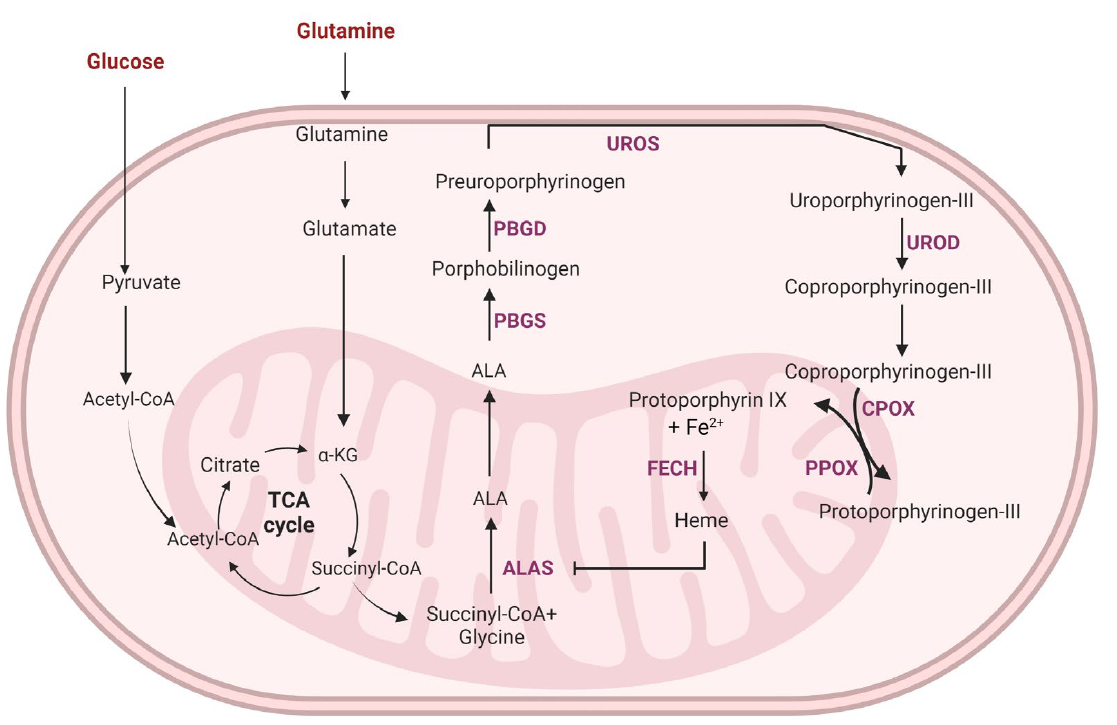
Figure 3. The heme biosynthesis is connected with glucose and glutamine metabolism. Enhanced glycolysis and glutaminolysis in the cancer cell might contribute to the elevated rate of heme synthesis and the upregulation of several heme biosynthesis pathway enzymes in the cancers. Addition of exogenous 5-ALA bypasses the feedback inhibition of ALAS and increase the accumulation of protoporphyrin IX (PpIX) in the cancer cells. The elevated accumulation of PpIX is exploited for fluorescence-guided detection (photodynamic diagnosis) of cancers. Further, irradiating PpIX-accumulating cancer cells with light generated singlet oxygen and ROS that kills the cancer cell, with minimal damage to the surrounding tissue (photodynamic therapy; PDT). The interdependency of glucose metabolism and the heme synthesis pathways suggest that targeting glycolysis could enable the modulation of PpIX accumulation in the cancer cells. The image was created using Biorender app. cell lines. Further, it was shown that up to 25% of the 5-ALA was used for glycolysis subsequent use as a photosensitizer for PDT and PD. Treating the glioblastoma cells